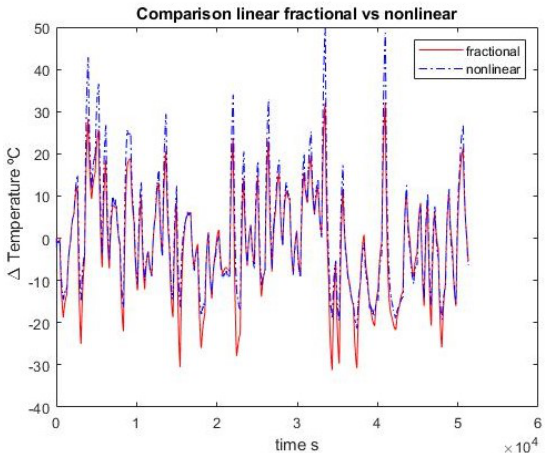
Figure 5. First fractional-order model. Identification.